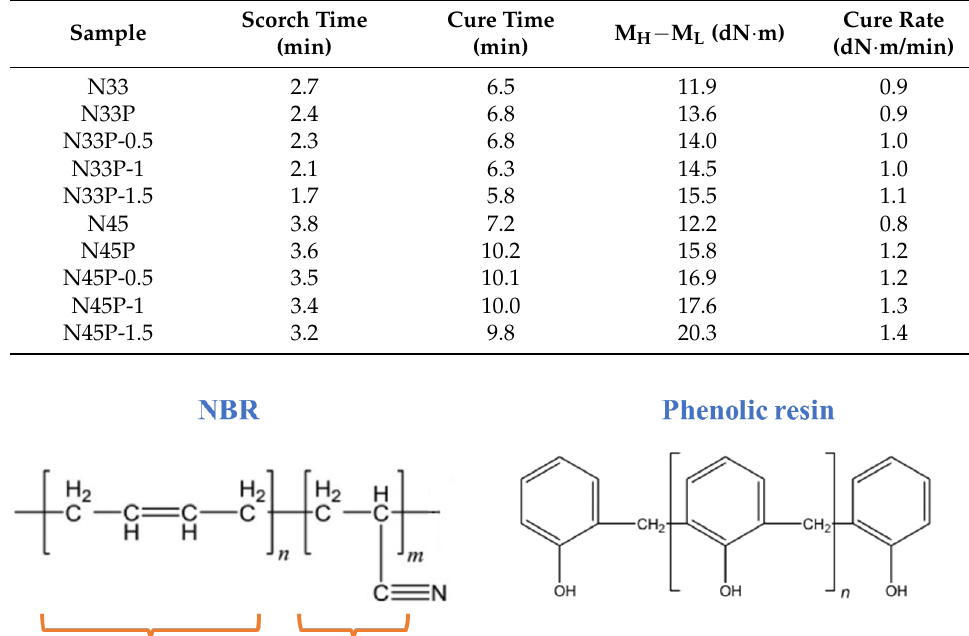
Table 3. Cure parameters of the samples.